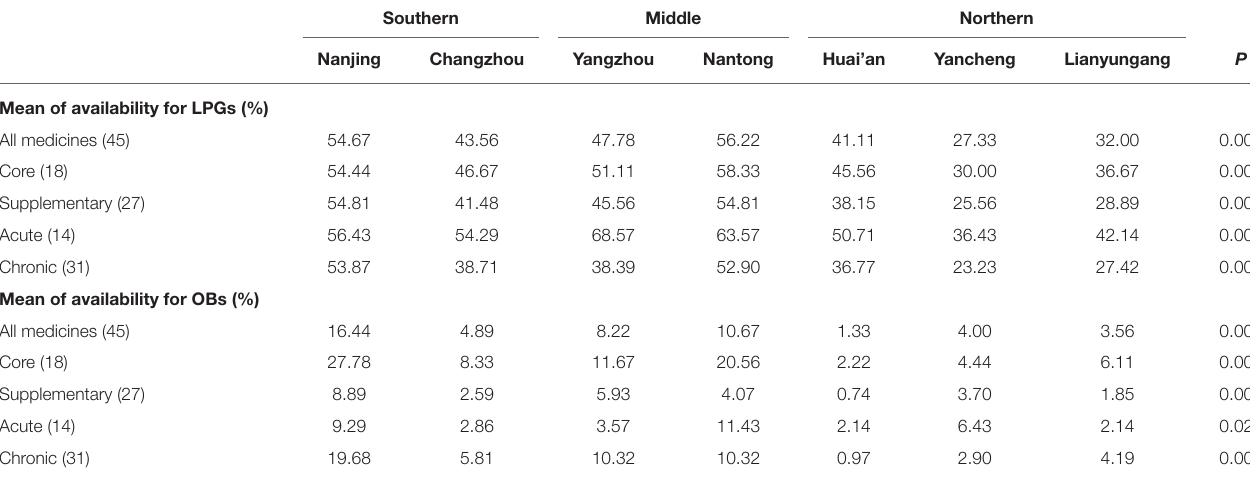
TABLE 7 | Mean availability of 45 essential medicines in seven cities. Southern Middle Northern